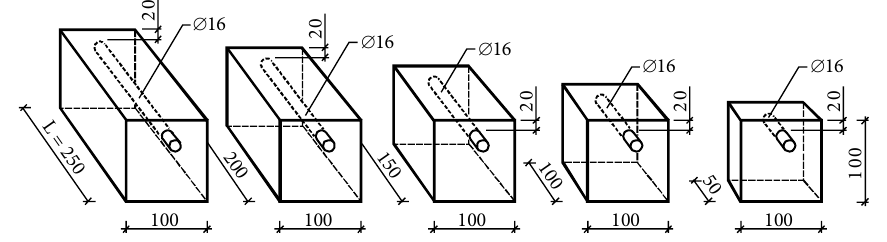
Fig. 2. The test elements of one